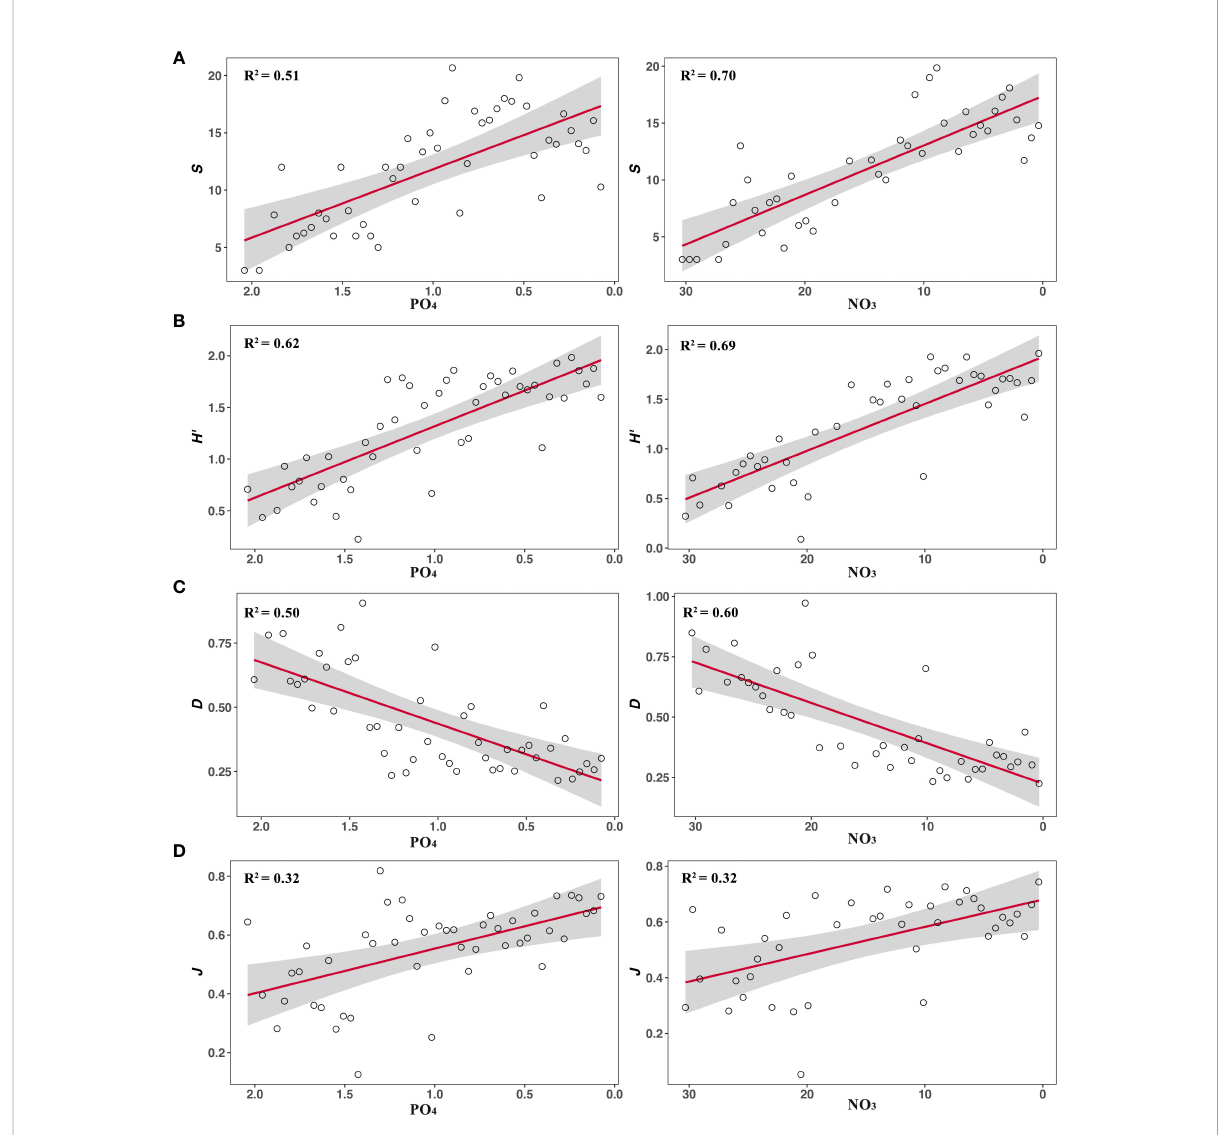
FIGURE 1 The N-Dc relationships are measured by (A) Species Richness ( S ), (B) Shannon ’ s index ( H ’ ), (C) Simpson ’ s index ( D ), (D) Pielou ’ s evenness ( J ). All metrics show the similar patterns with changes in PO 4 and NO 3 . The red line represents the regression result and the gray shading represents the 95% con fi dence